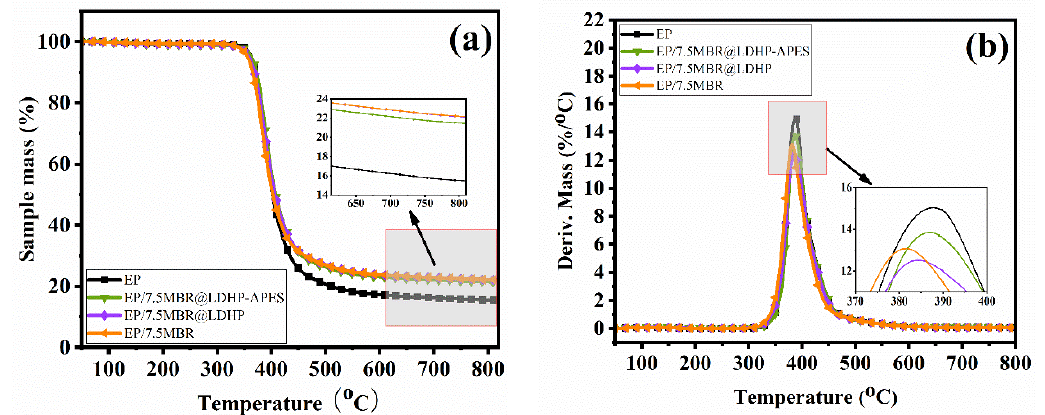
Figure 4. TG ( a ) and DTG (derivative thermogravimetry) ( b ) curves for EP and EP/7.5MBR@LDHP- APES, EP/7.5MBR@LDHP, EP/7.5MBR. Table 3. TG data for EP and its composites.